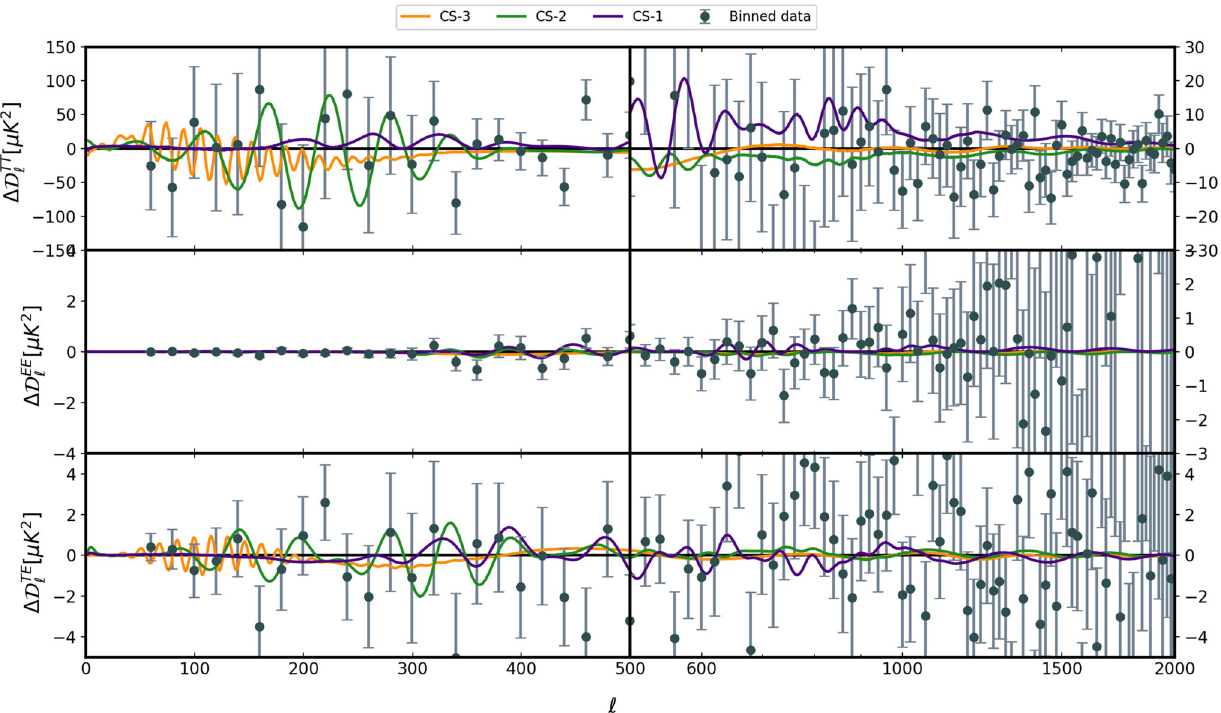
Fig. 5 Residual plots corresponding best-fit candidates to CamSpec clean TTTEEE + lowT + lowE likelihood. Here residual is calculated from the power-law (cid:2) CDM model. Zero line corresponds to the power-